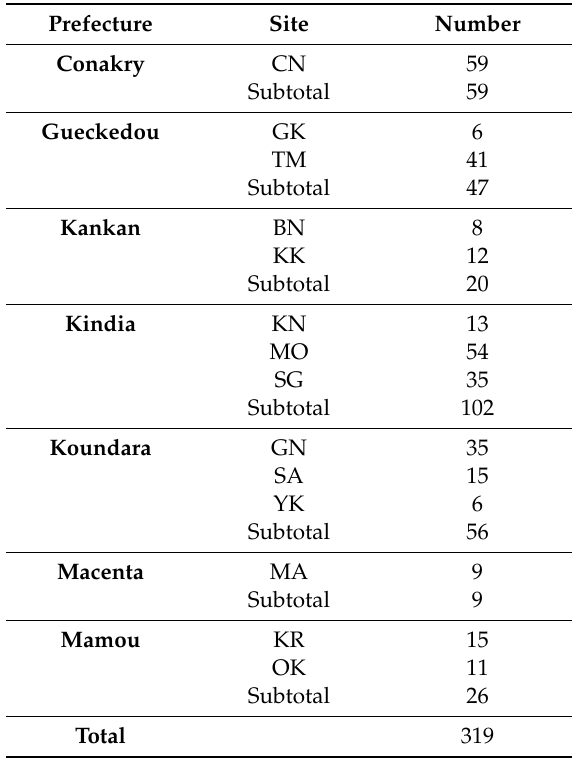
Table 1. Number of bat samples collected at each study site in the di ff erent prefectures in Guinea. Prefecture Site Number Conakry CN 59 Subtotal 59